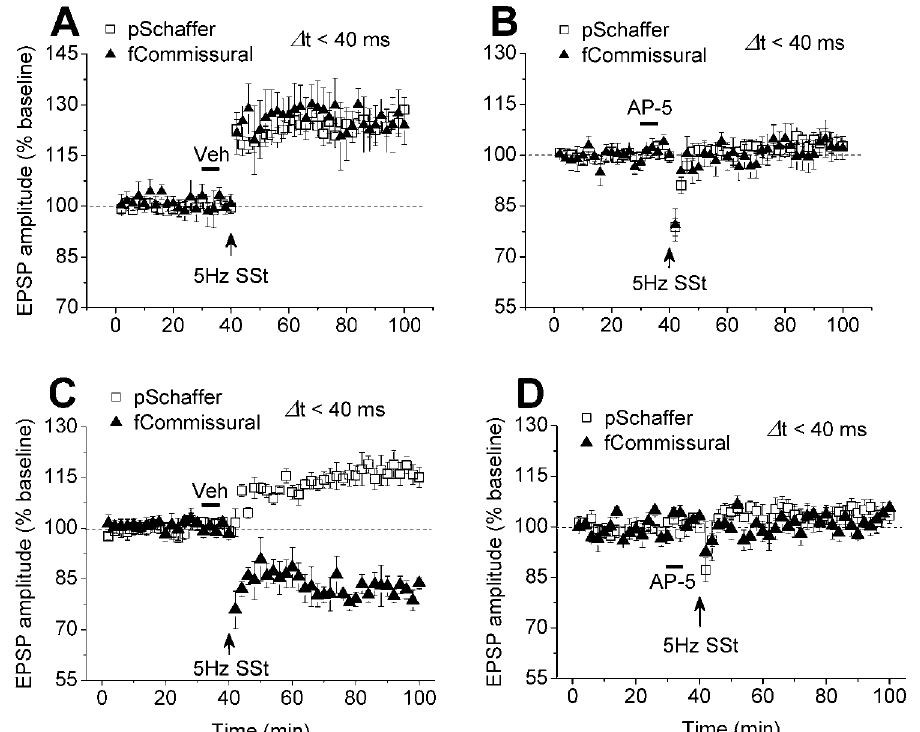
Figure 4. The activity-dependent synaptic plasticity depends on NMDAR. A , Intracerebroventricular infusion of vehicle did not prevent the stimulation to Schaffer preceding commissural pathway ( D t , 40 ms) from inducing LTP in both pathways in pentobarbital-anesthetized rats (n=5; Schaffer: 125.7 6 3.2%; commissural: 123.9 6 6.2%; P , 0.001 vs. baseline of Schaffer or commissural). B , Infusion of the NMDAR antagonist AP-5 prevented the stimulation to Schaffer preceding to commissural pathway within a 40-ms window from inducing LTP in both pathways (n=6; Schaffer: 103.6 6 2.2%, P=0.349 vs. baseline; commissural: 103.0 6 4.1%, P=0.463 vs. baseline). C , Similarly, infusion of vehicle did not affect the stimulation to Schaffer preceding to commissural pathway within a 40-ms window to induce LTP in preceding and LTD in following pathway in urethane-anesthetized rats (n=6; Schaffer, 116.8 6 3.2%; commissural, 81.4 6 2.3%, P , 0.001 vs. baseline of pSchaffer or fcommissural). D , Infusion of the NMDAR antagonist AP-5 prevented the stimulation to Schaffer preceding to commissural pathway within a 40-ms window from inducing LTP and LTD (n=4; Schaffer: 103.8 6 2.9%, P=0.163 vs. baseline; commissural: 102.6 6 2.4%, P=0.493 vs. baseline).